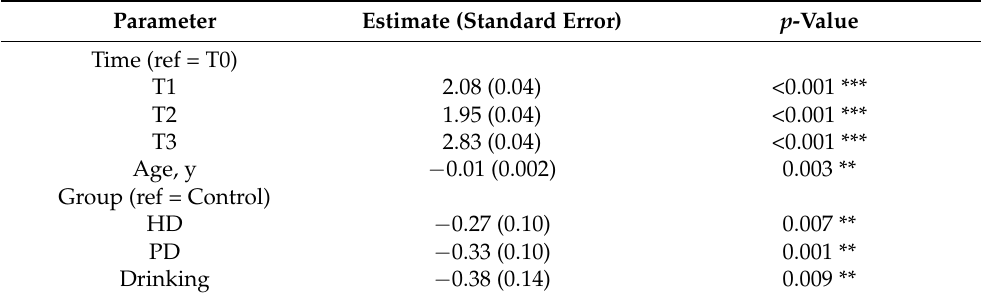
Table 3. Timeframe and factors associated with log SARS-CoV-2 RBD IgG levels adjusted for age, sex, BMI, smoking, drinking, dialysis modality, and